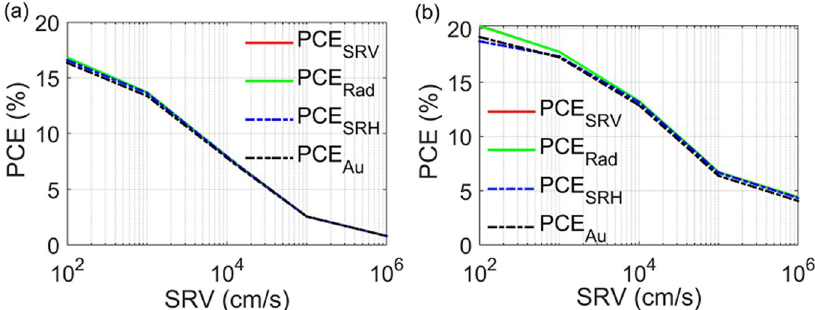
Figure 18. The PCE of the proposed and conventional NW designs in the axial and core–shell junction for Rad, SRH, and Au recombination mechanisms separately under different SRVs values.